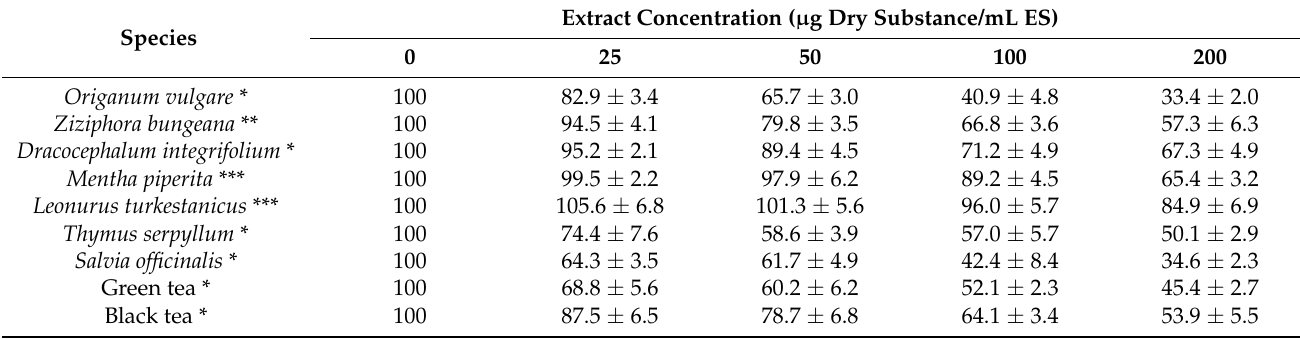
Table 2. Influence of herbal extracts of family Lamiaceae on osmotic resistance of erythrocyte membrane. Note: mean ± SD, n = 3. The extent of hemolysis was calculated as the percentage of total hemolysis caused by 0.1% Na 2 CO 3. Extract Concentration ( µ g Dry Substance/mL ES) Species 0